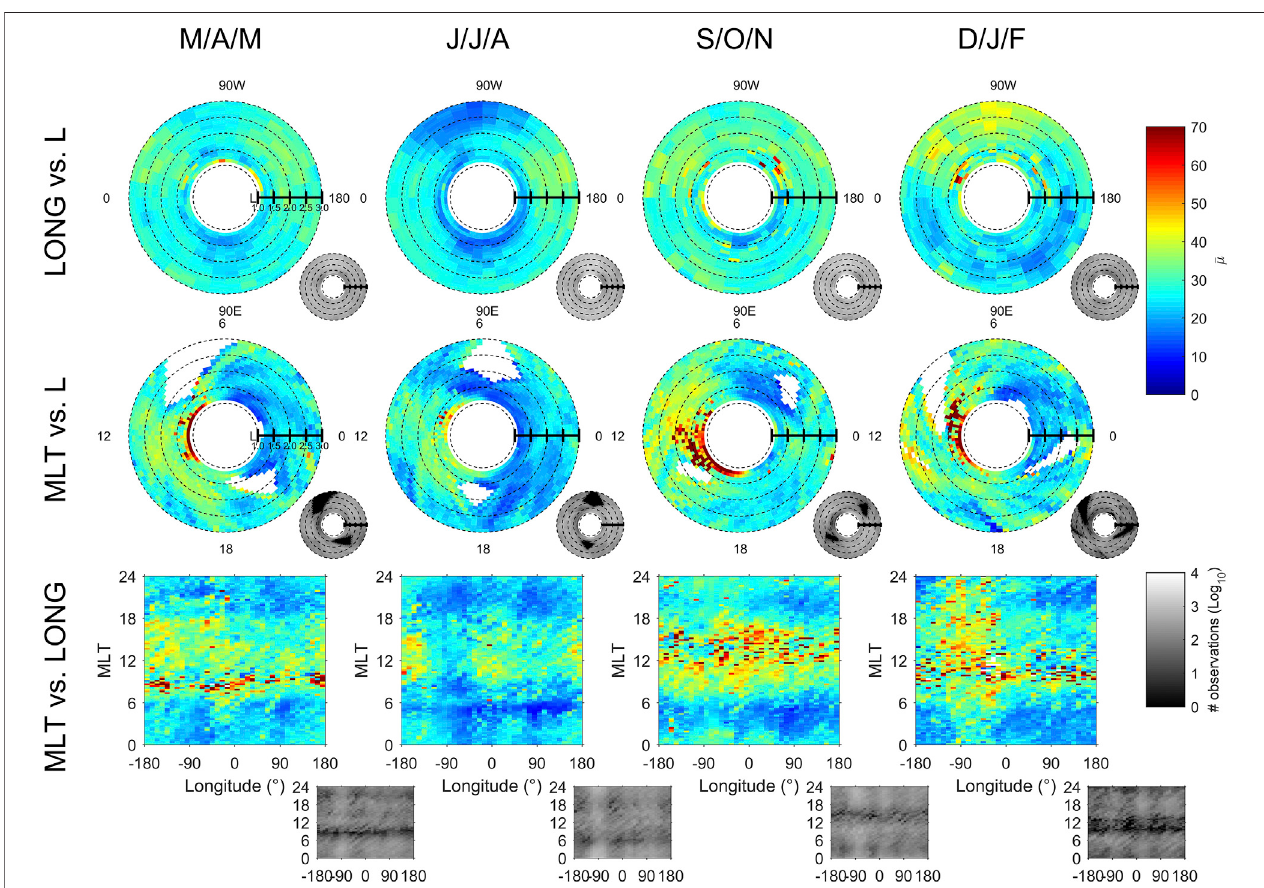
FIGURE9| Columntableofgraphicpairs.EachpairhasalargemapdepictingtheVanAllenProbesrefractiveindex,µ,andalowerrightauxiliarymapdepictingthe probescoverageinnumberofobservations.Columnscorrespondtofourseasons(withM/A/MforMarch/April/May,etc.),androwsshowtheVanAllenProbesrefractive index marginalized over MLT (i.e., plotted versus longitude and L-shell), longitude, and L-shell, respectively.